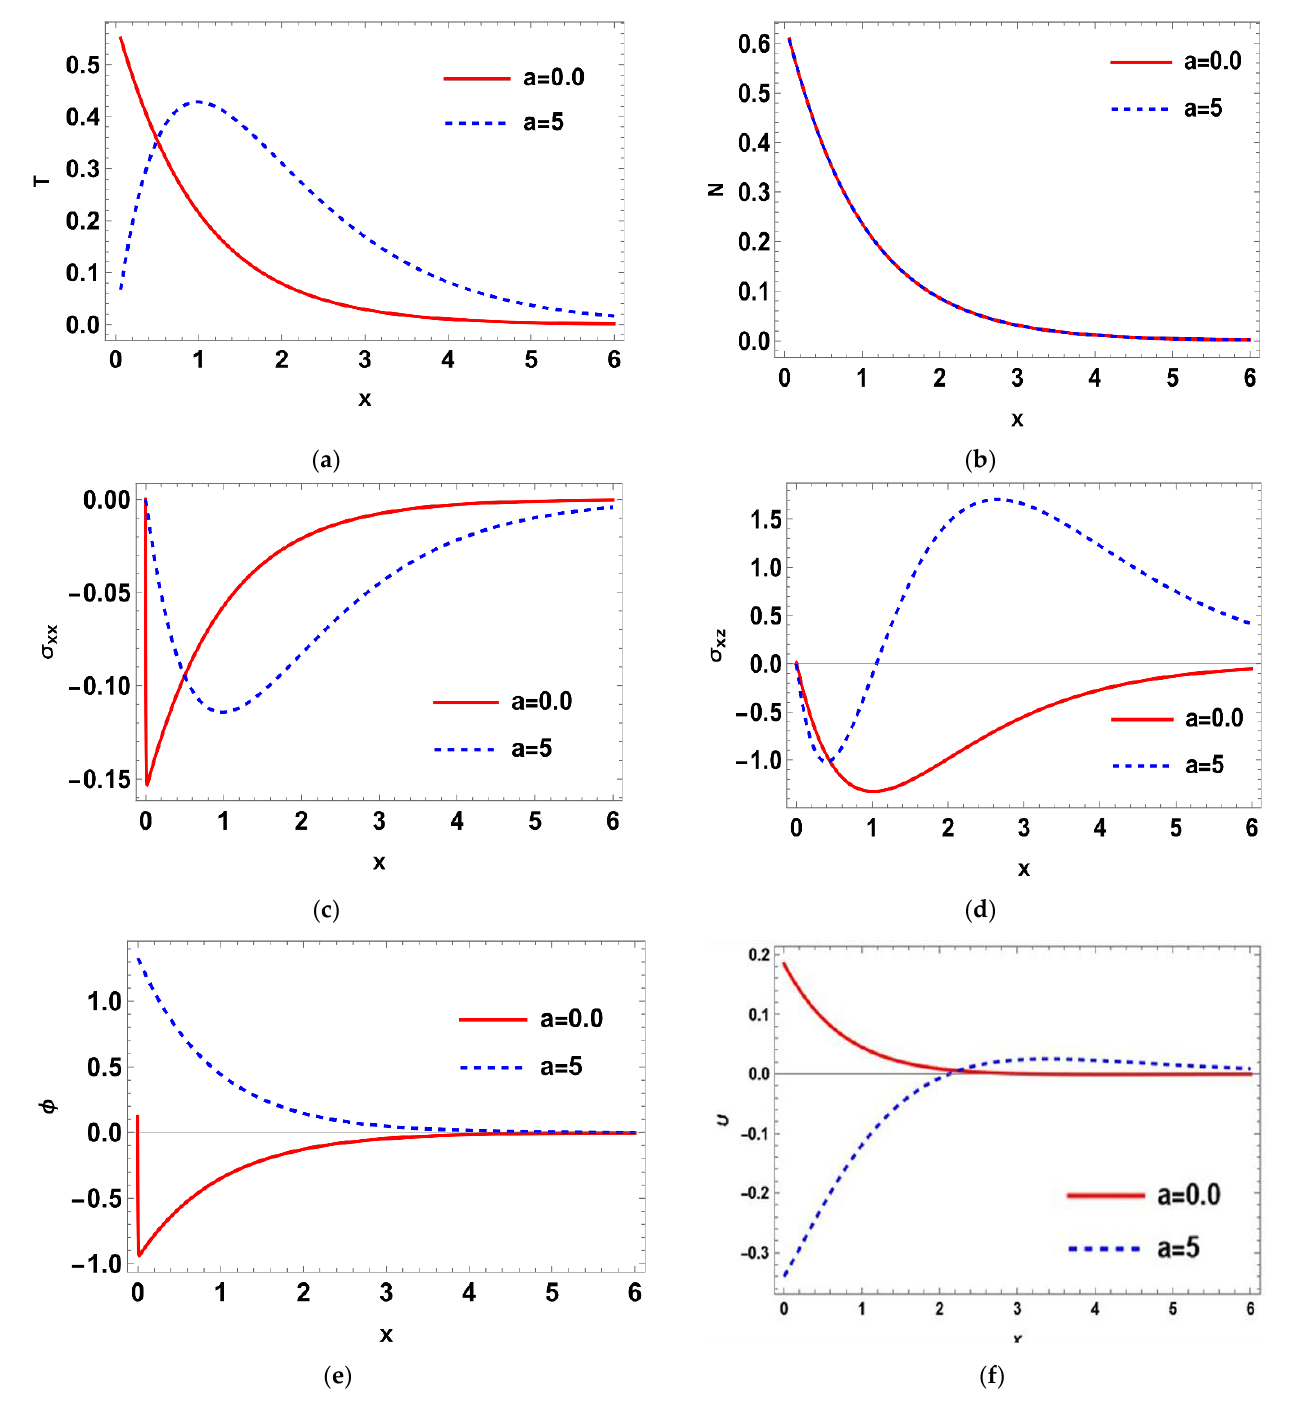
Figure 7. ( a – f ) A comparison between deterministic cases at different values of two temperature parameter, namely; 0 a = and 5 a = when 0.4 t = . parameter, namely; a = 0 and a = 5 when t =